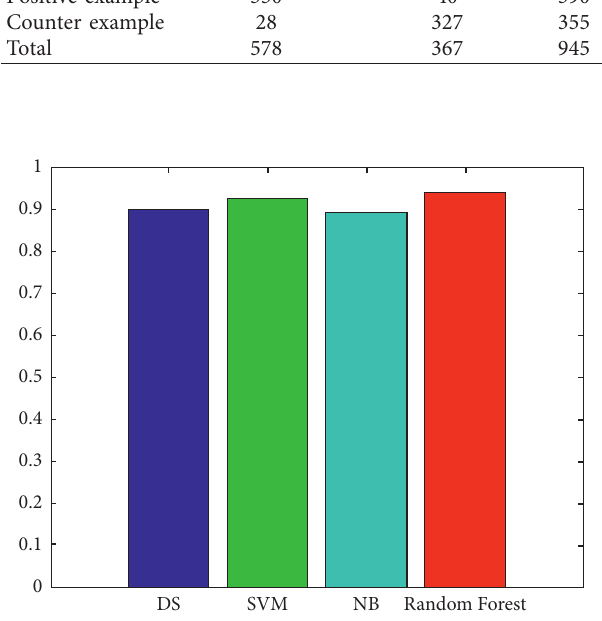
Figure 1: Comparison of precision rates.